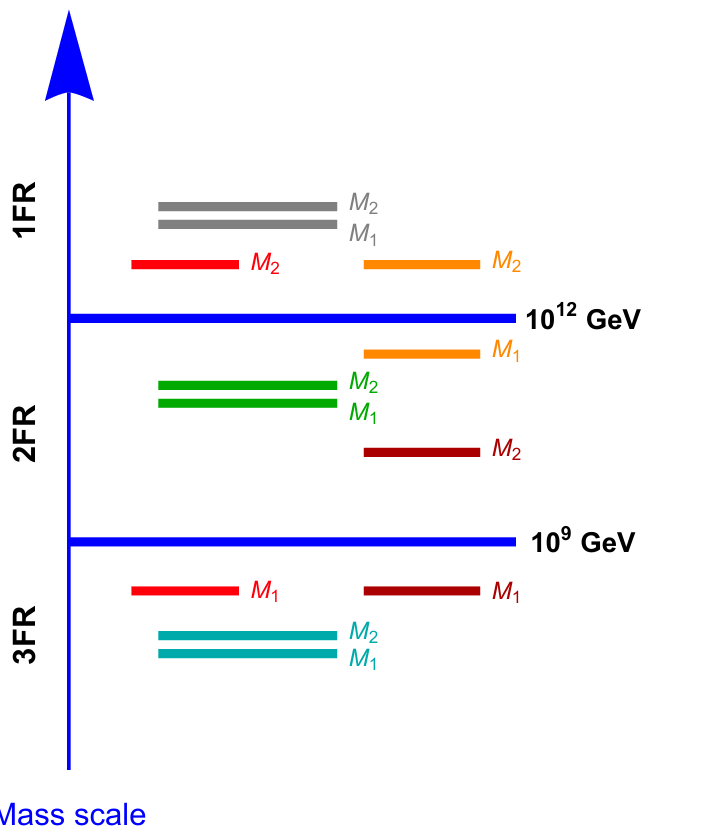
Figure 5 . Various mass pattern in a leptogenesis scenario dominated by two right handed neutrinos. A particular RH neutrino mass which is either above 10 12 GeV or below 10 9 GeV, can not generate baryon asymmetry in the CP (cid:22)(cid:28)